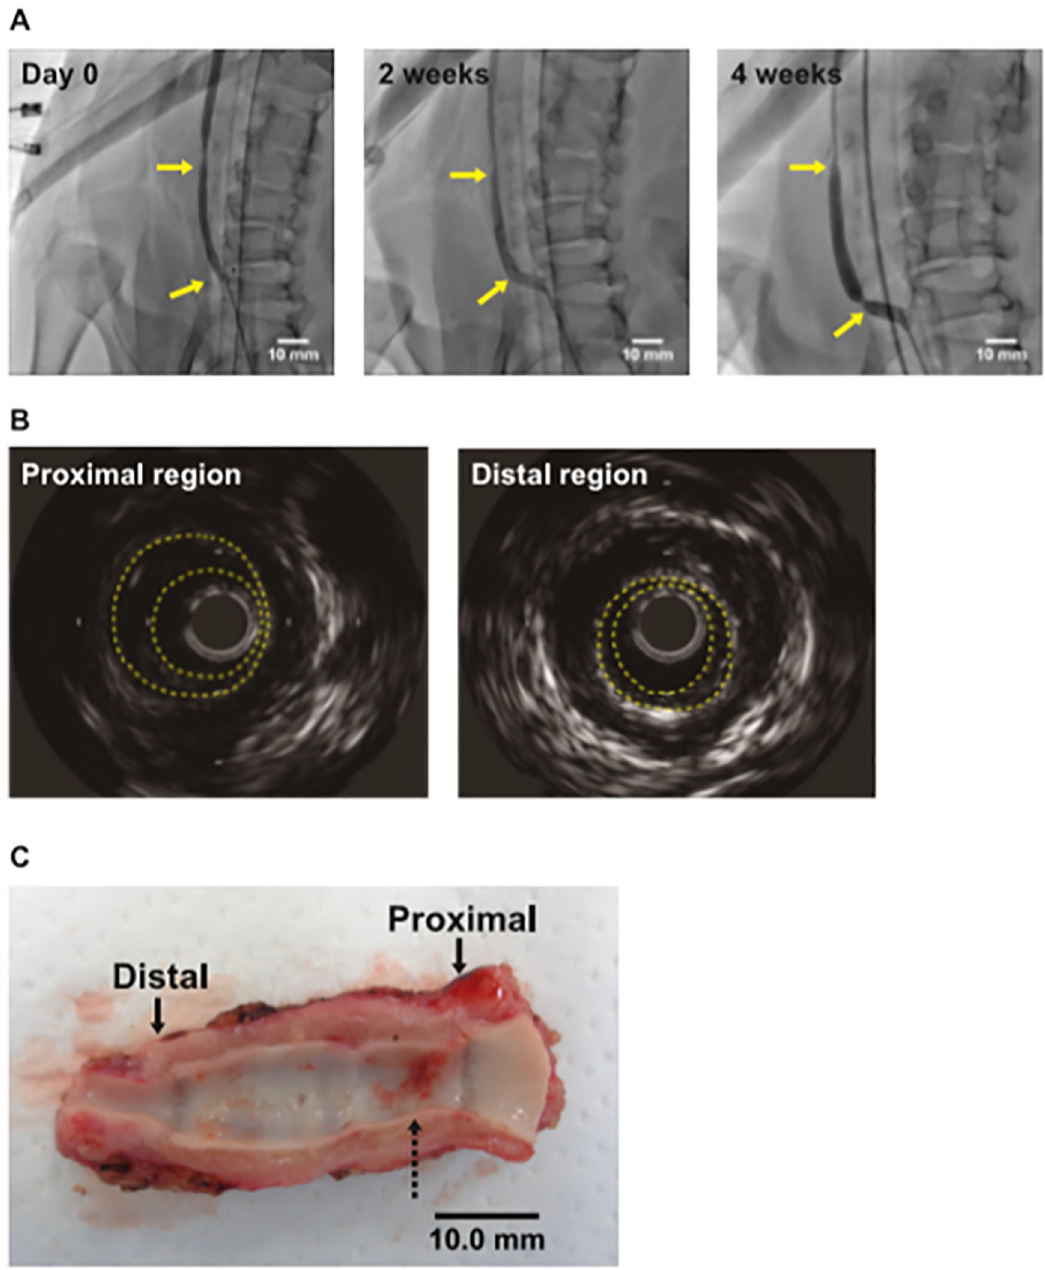
Fig 3. Evaluation of the implanted graft patency and morphology. ( A ) Representative images of angiography of implanted grafts at just after implantation (left), and 2 weeks (middle) and 4 weeks (right) after implantation, respectively. Yellow arrows indicate anastomosis sites. ( B ) Representative images of IVUS. Left; proximal region, right; distal region. ( C ) A representative macroscopic view of explanted graft. Arrows indicate anastomosis sites. Dotted arrow indicates thrombi. decellularized grafts exhibited acellular smooth surface without endothelium (Fig 5B). The luminal surface of decellularized bovine graft implanted at porcine carotid artery for 4 weeks showed endothelium with cobblestone-like appearance by fair recellularization similar with those in bovine and porcine native arteries (recipient animal) (Fig 5A, 5C and 5D).